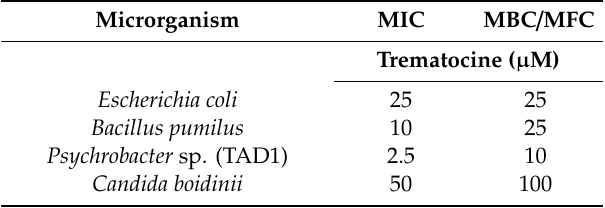
Table 3. Antimicrobial activity of Trematocine.